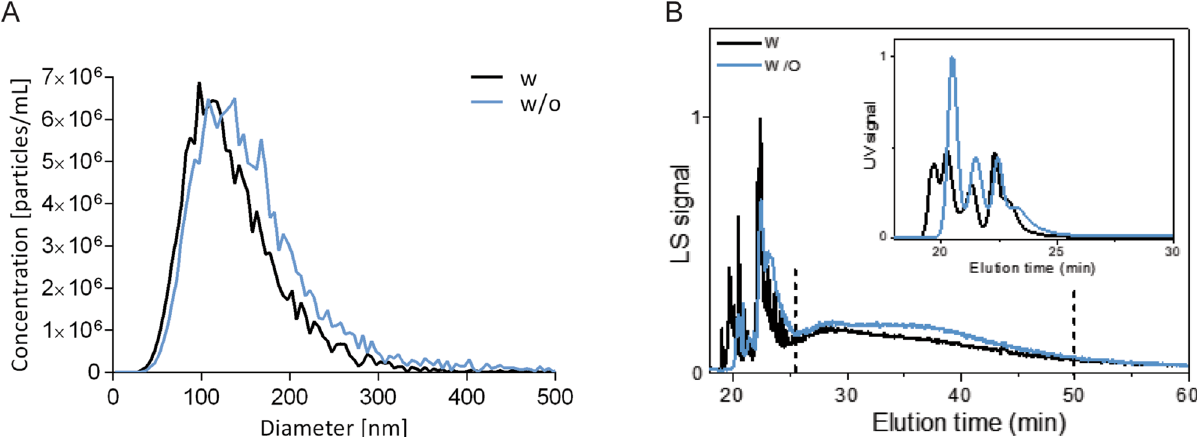
Figure 7. Effect of digestion with proteinase K and DNase-I on particle size and concentration after enrichment with sUC. ( A ) Quantification of size and concentration of nanoparticles human blood plasma sample with (black line) or without (blue line) treatment with proteinase K and DNase-I by NTA. Lines represent the average particle values of four independently sUC-enriched and treated aliquots of the same sample with and without enzymatic digestion. ( B ) Quantification of size and concentration of nanoparticles in human blood plasma sample with (black line) or without (blue line) treatment with proteinase K and DNase-I by AF4-UV-MALS. Fractograms present average MALS and UV signals in relation to elution time of three independently sUC- enriched samples with and without enzymatic digestion. NTA nanoparticle tracking analysis, AF4-UV-MALS asymmetrical flow field-flow fractionation with ultraviolet and multi-angle light scattering detectors, sUC sucrose cushion